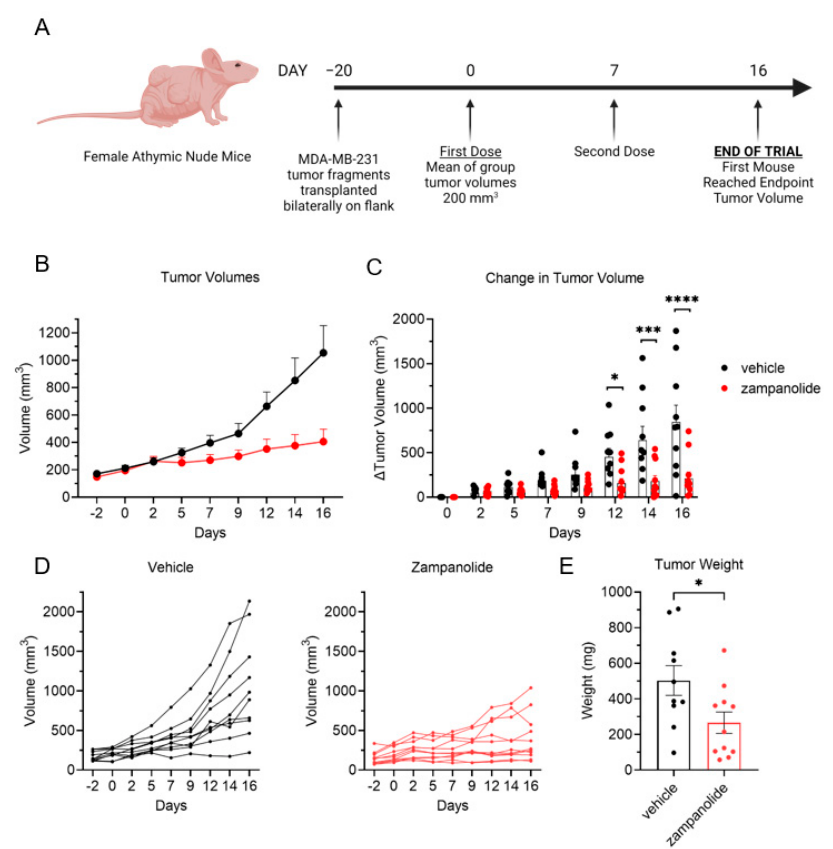
Figure 5. Antitumor efficacy of zampanolide in MDA-MB-231 TNBC tumors. ( A ) Timeline of tumor trial. Female athymic nude mice with bilateral MDA-MB-231 tumors were injected intratumorally with 15 µg zampanolide ( n = 10) or 3 µL DMSO in 100 µL PBS vehicle ( n = 11). ( B ) Tumor volumes of vehicle and zampanolide groups over time as average ± SEM. ( C ) Change in tumor volume of vehicle and zampanolide groups over time as average ± SEM showing individual values. Significance determined by two-way ANOVA with Sidak’s multiple comparisons. ( D ) Spider plot of individual tumor volumes from vehicle and zampanolide treated animals. ( E ) Final weight of each tu- mor from vehicle and zampanolide treated animals. Significance determined by unpaired T-test. * p < 0.05, *** p < 0.001, **** p < 0.0001.